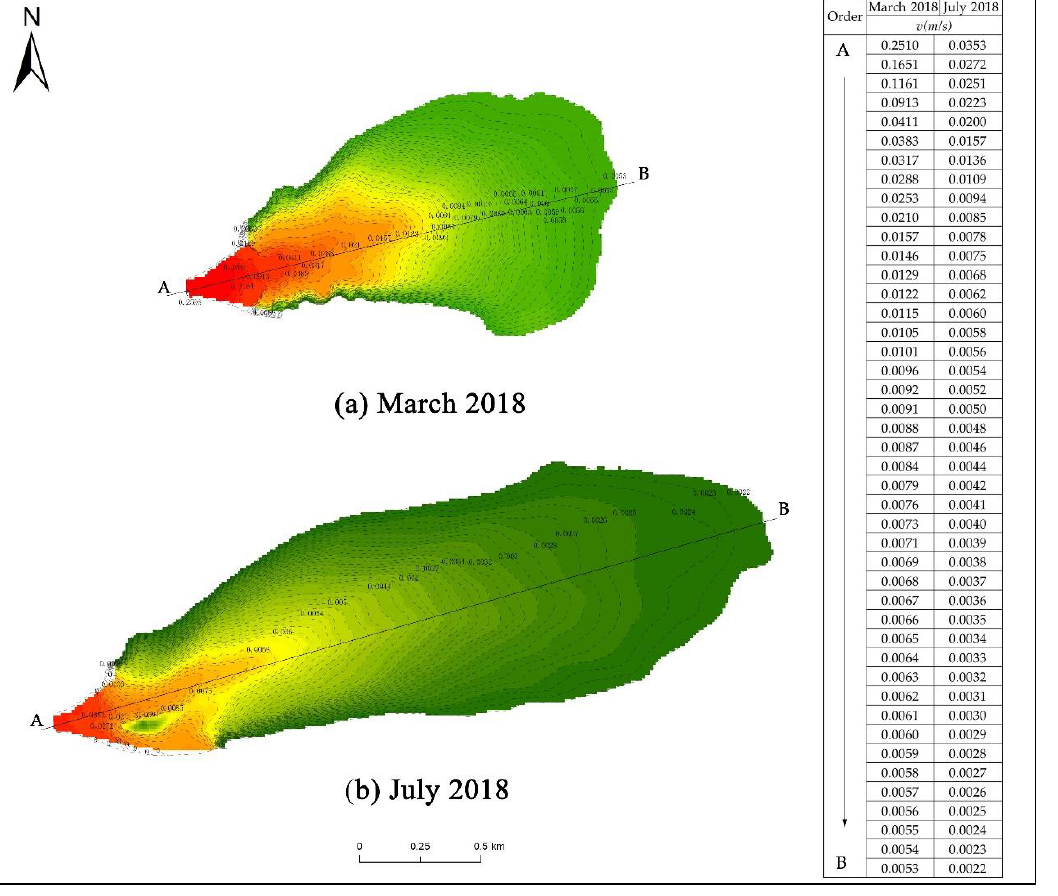
Figure 11. Distribution of flow velocities in the Fu River–Baiyangdian Lake transition zone. ( a ) March 2018, when the range of the transition zone is smallest, ( b ) July 2018, when the range is largest. Charts for the flow fields in other months are shown in Appendix B Figure A1. Table 2. Calculation of the flow velocity gradients G ij and G ki in the Fu River–Baiyangdian Lake transition zone. Figure 5 shows the positions of lines k , i , and j .